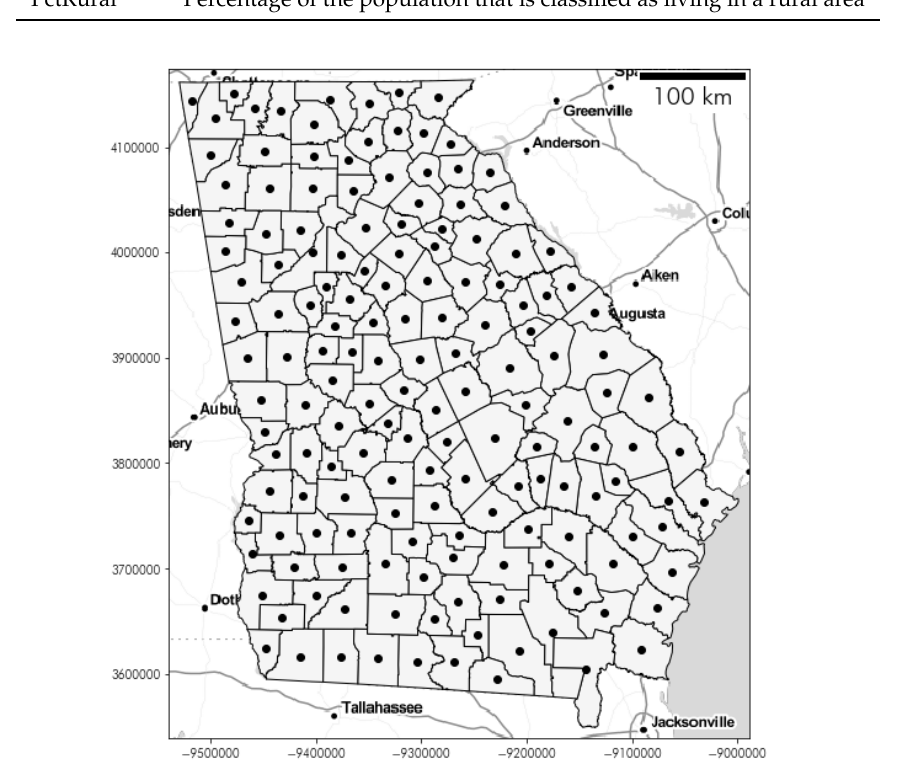
Figure 1. The 159 counties within the state of Georgia. Note: basemap and scalebar added using additional